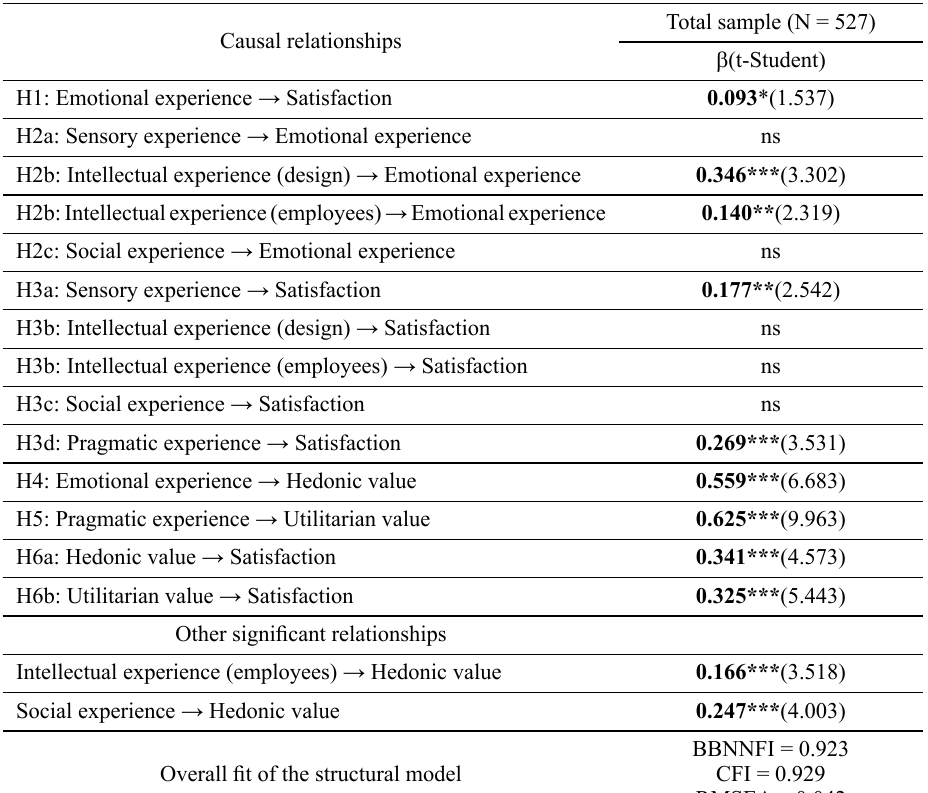
Table 5. Results of Structural Equation Model